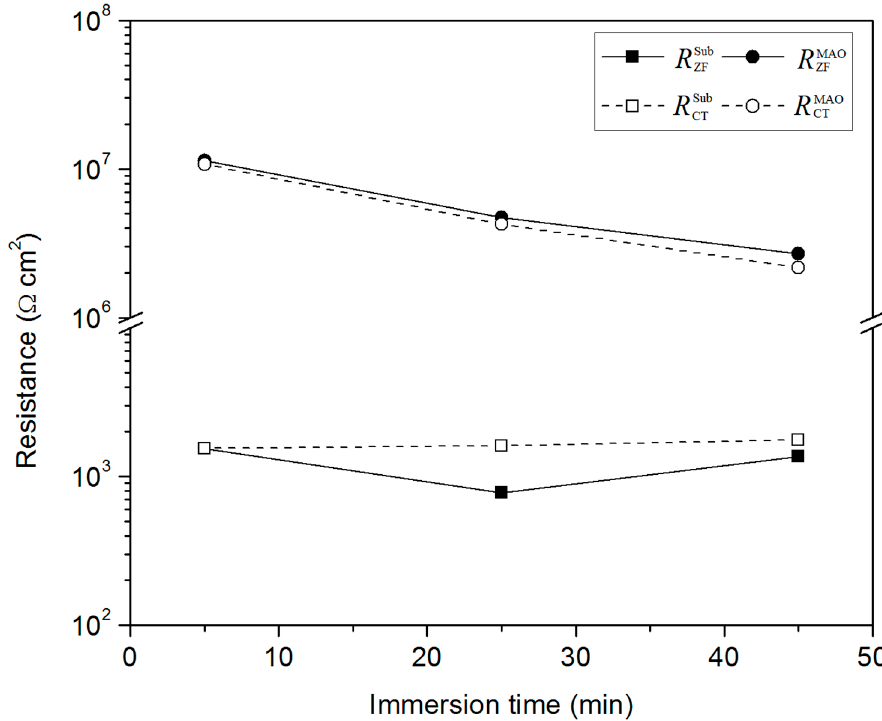
Figure 9. Comparison of R CT and R ZF of AZ91 alloy and MAO-coated alloy from fitted EIS results at different immersion times in a 3.5% NaCl solution.